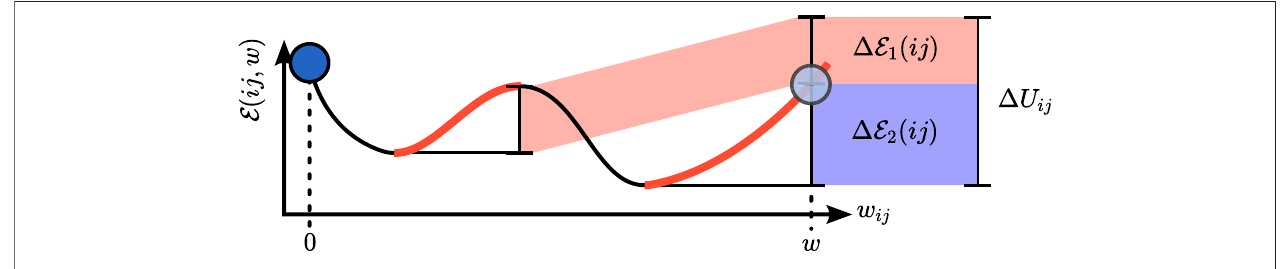
FIGURE 4 | Event-driven approach to determine the rejection distance for a pair interaction between i and j . Condition (13) has to be solved for the rejection distance w ij atwhichanevent/liftingoccurs.TheblackcurveistheinteractionenergyalongtheECdirection.Onlyonredsegmentswithincreasingenergyarejectioncan occur. Among all pair interactions, the rejection will be assigned to the interaction with the smallest rejection